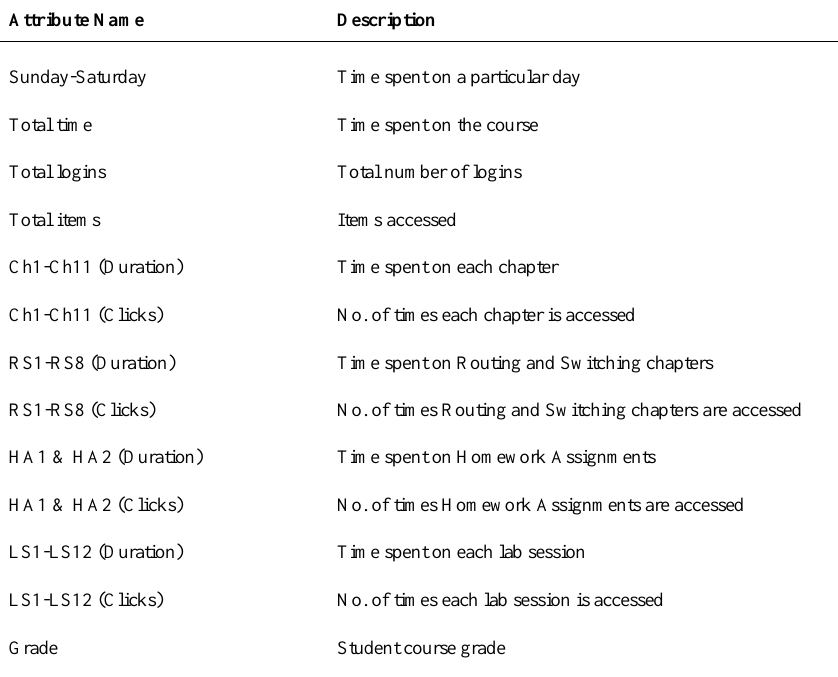
Table 1. Variables evaluated for the